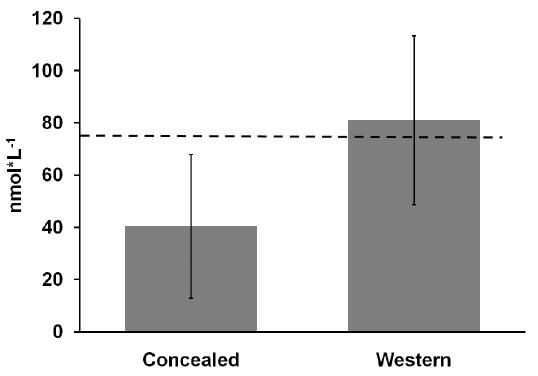
Figure 1. The means ± SD of serum 25-hydroxyvitamin D (s-25(OH)D) levels for women who wore concealing clothing compared to pair matched women who dressed according to western norms. The dashed line represents the level of s-25(OH)D that is considered to be sufficient.